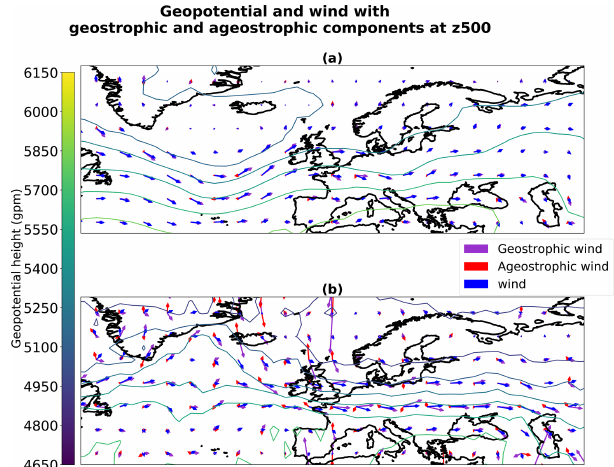
Figure 19. Geostrophic and ageostrophic wind derived from geopo- tential at 500hPa. Situation taken from dataset (a) and gener- ated (b) .